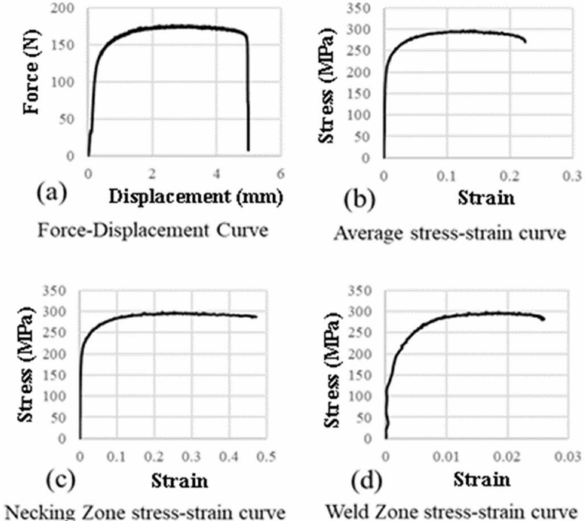
Figure 10. Diagrams showing ( a ) force − displacement curves and ( b – d ) stress − strain curves repre- senting various stages/places during tensile testing on the 100 µ m thick foil, with 50 W of power and at a speed of 20 mm/s.